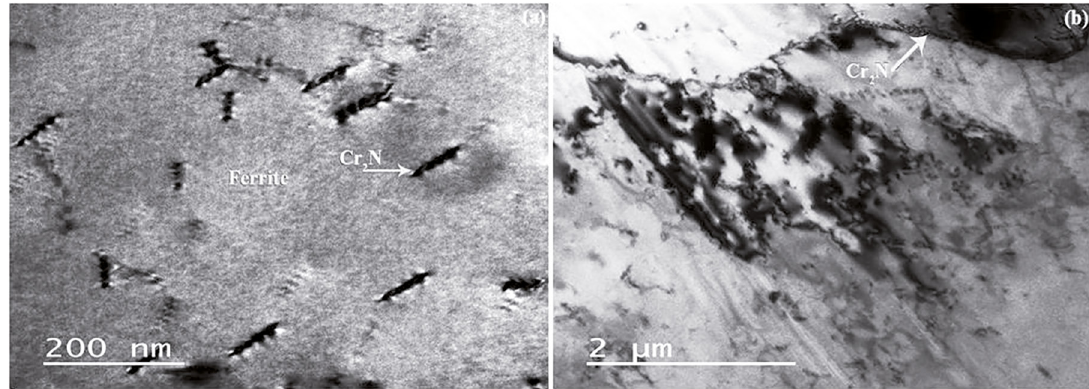
Figure 3: Transmission electron micrograph of Cr2N of the HAZ of welded joints. (a) Transmission electron micrograph of the intragranular nitrides and (b) transmission electron micrograph of the nitrides precipitated at the ferrite/austenite interfaces (FCAW top region and 2307 as filler